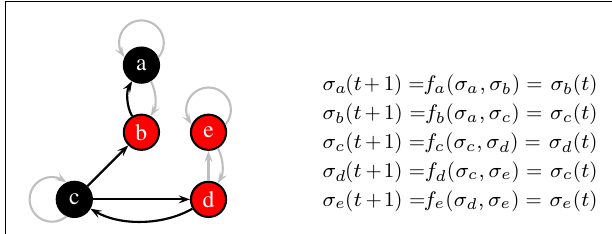
FIGURE 1 |At the current time step, node a and c are off (0, black), the others are on (1, red). The functions f a ... e with K = 2 effectively depend only on one input, non-used links are grayed-out. Here, all functions describe a simple “copy”-operation, e.g., f a says that node a will take the value σ b at the next time step.